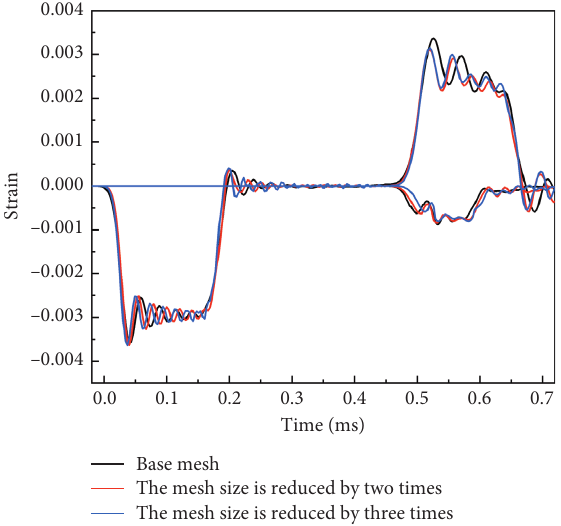
Figure 4: Numerical simulation results with different mesh